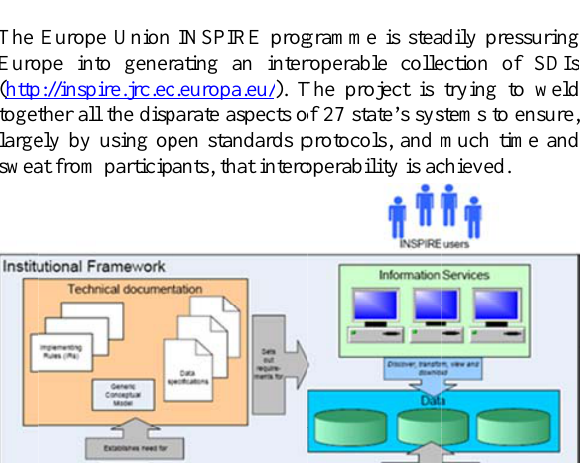
Figure 57: fro quality,